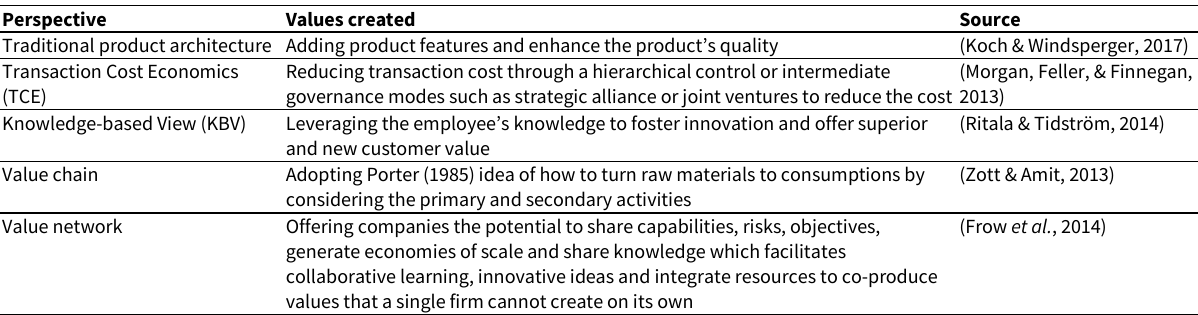
Table 9. Value creation perspectives in